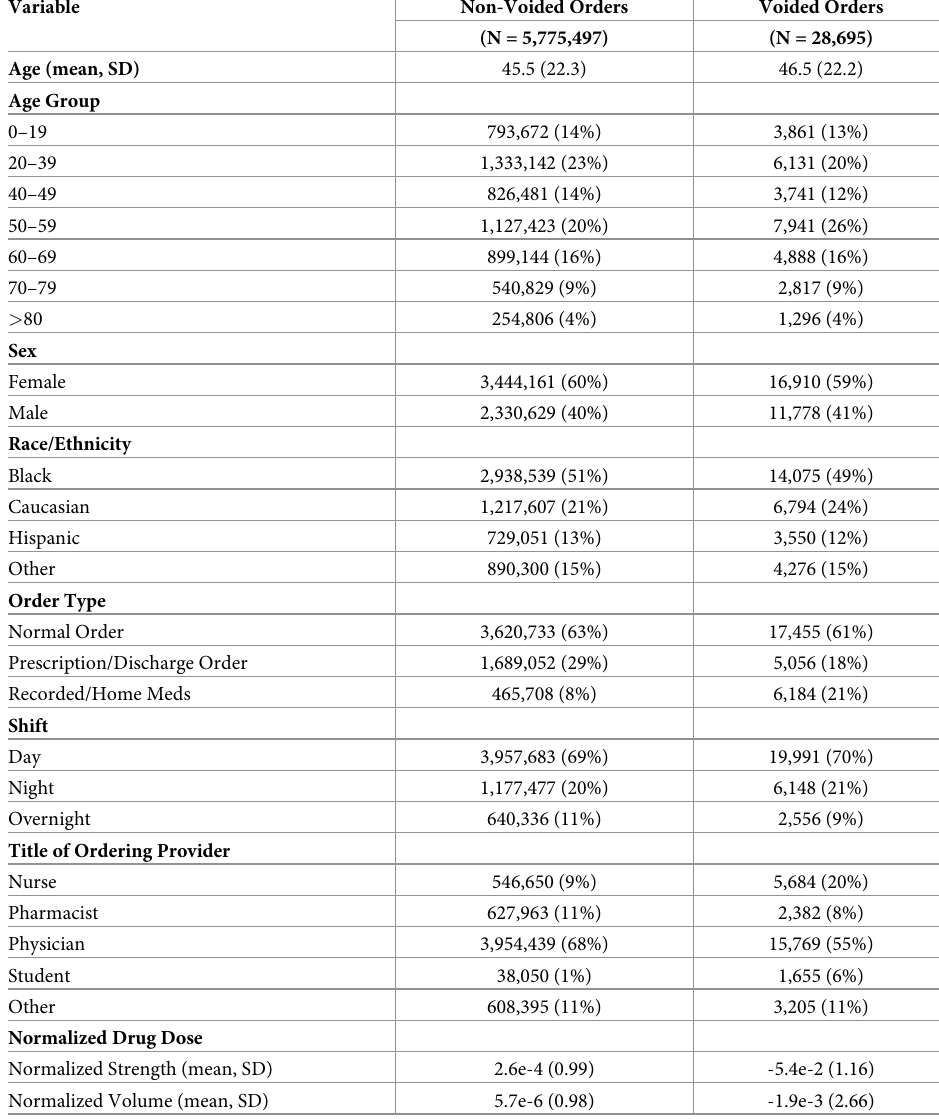
Table 1. Characteristics of orders in the